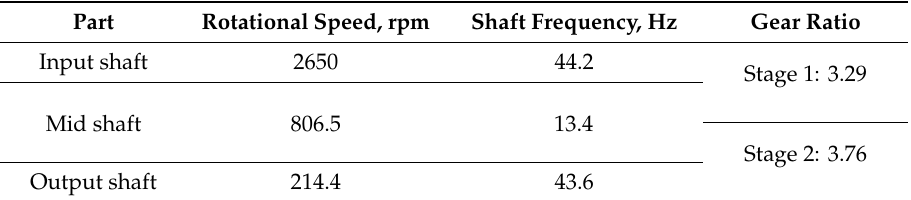
Table 1. Rotational speed of the shaft at the rated speed.